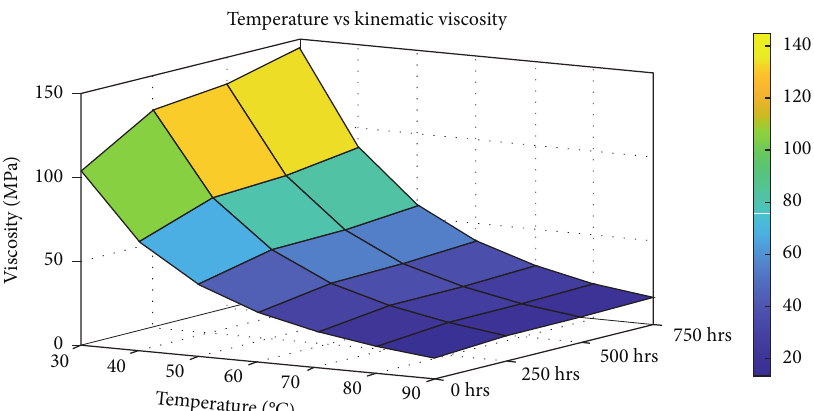
Figure 10: Change in kinematic viscosity with respect to temperature.